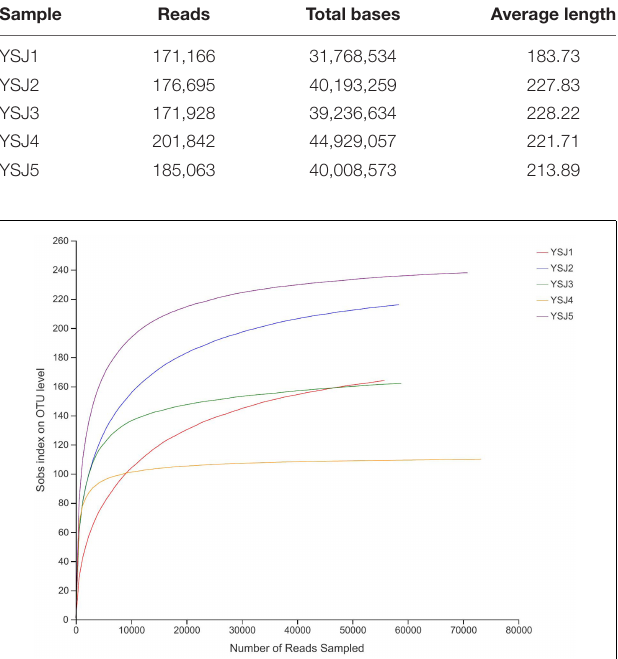
FIGURE 1 | Rank abundance curves of all samples. The abscissa represents the rank number of operational taxonomic units (OTUs), and the ordinate represents the relative percentage of species at the classification level. The position of the abscissa of extension end point of the sample curve represents the number of species in each sample. Smooth curves indicate higher species diversity, while steep decline indicates a high proportion of bacterial strains and low fungal